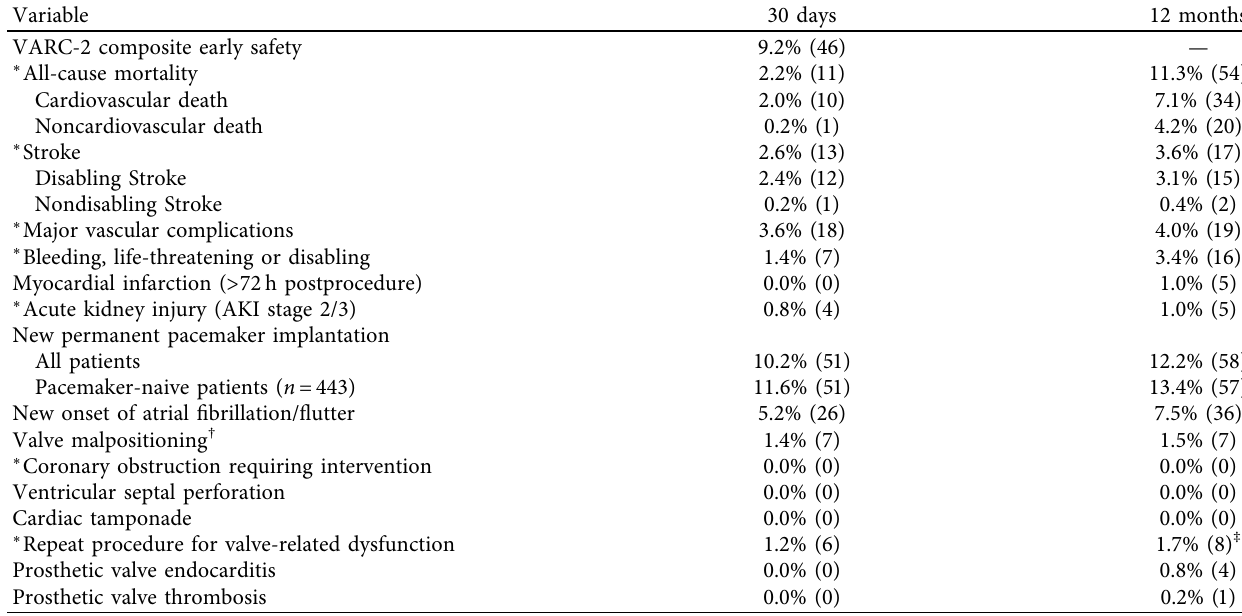
Figure 4: Change in valve hemodynamics. (a) Patients treated with ACURATE neo demonstrated improvements in mean aortic valve gradient and mean effective orifice area through 12-month follow-up, as assessed by an independent echocardiography laboratory. (b) Paired analyses of core laboratory data at discharge, 30 days, and 12 months demonstrate early hemodynamic improvement on a per-subject basis, which was maintained through 12 months. Table 2: Clinical safety